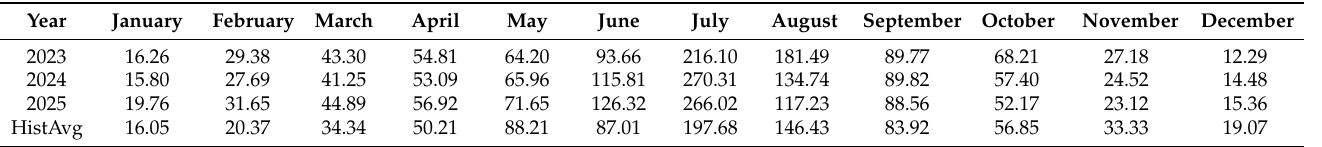
Table 6. Prediction results of the coupled CEEMD-LSTM-LSSVM model of monthly precipitation in Zhoukou City from 2023 to 2025.